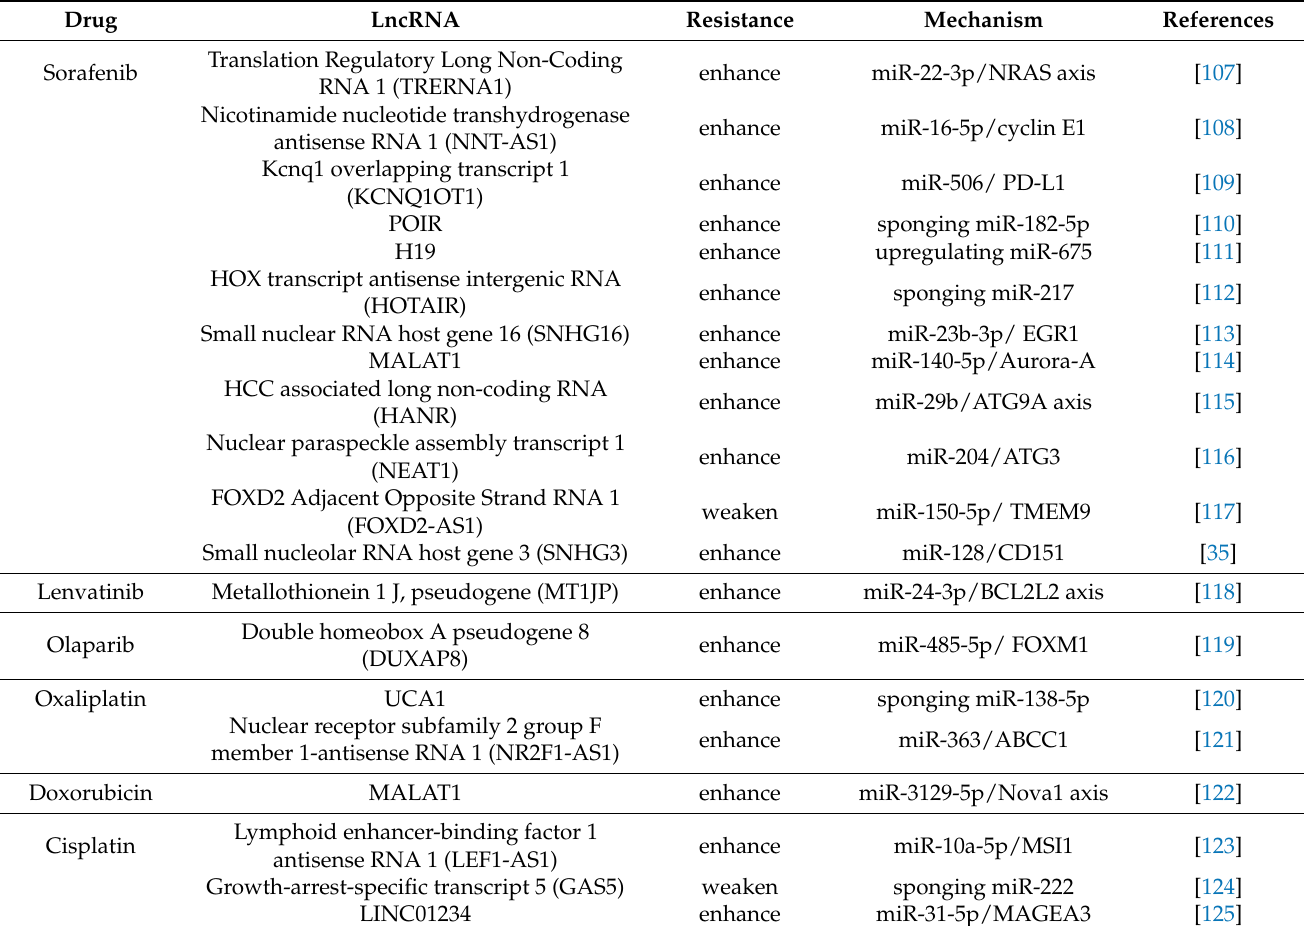
Table 4. LncRNA and miRNA networks in hepatocellular carcinoma therapy resistance.